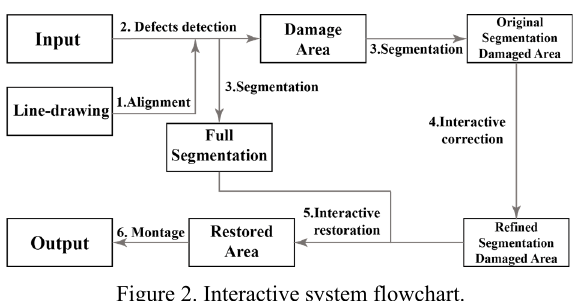
Figure 2. Interactive system